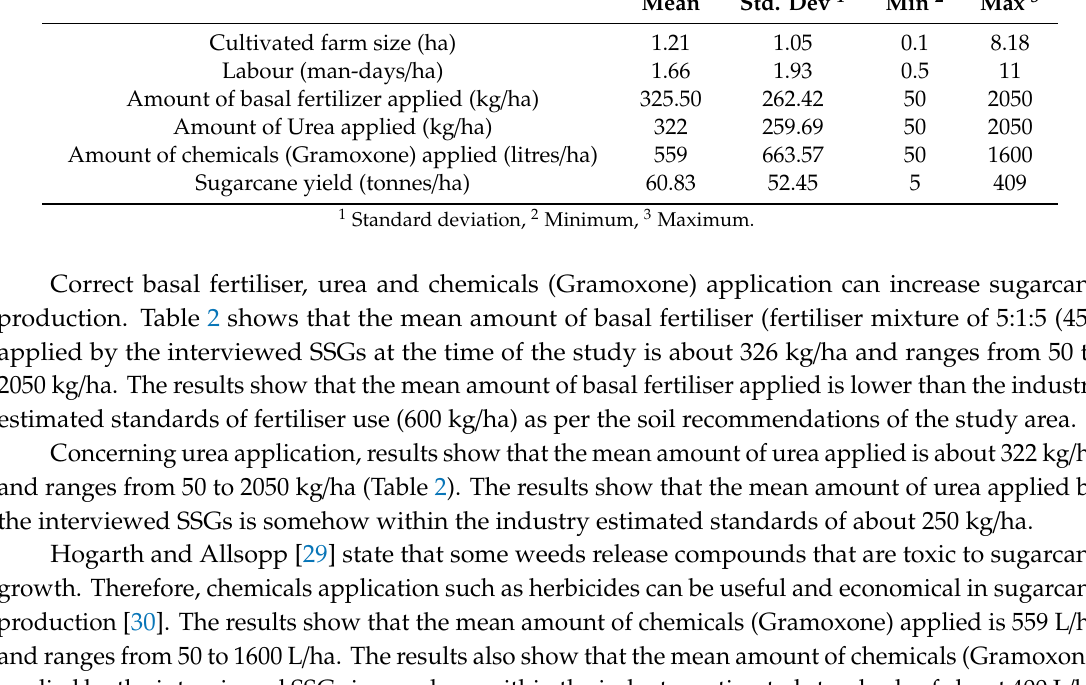
Table 2. Summary of farm characteristics of the interviewed sugarcane small-scale growers ( n = 100).